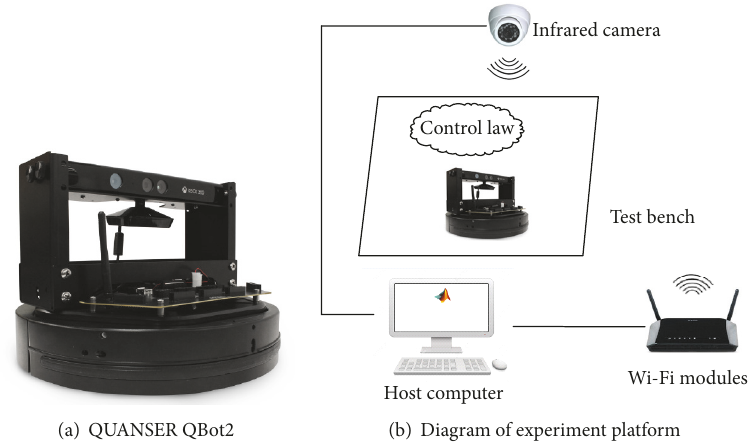
Figure 5: Experimental environment.